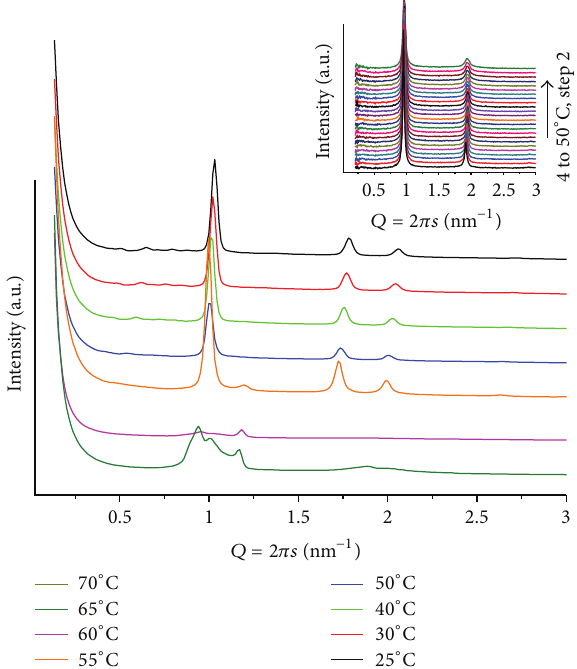
Figure 1: SAXS patterns at different temperatures for POPC/ANQ, mr = 50 and pH = 4 . The inlet contains a heating scan of fully hydrated pure POPC from 𝑇 = 4 to 𝑇 = 50 , step 𝑇 = 2 .